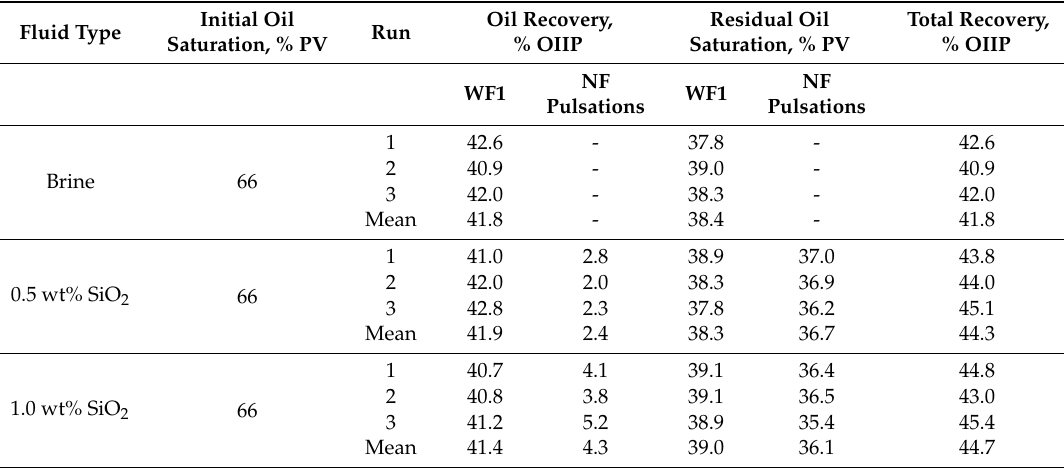
Table 4. Summary of sand-pack experiments where the initial water and oil volumes are fixed at 93.2 mL and the initial oil volume is 186.4 mL, respectively. Where %PV is the percentage of pore volume, OIIP is the oil initially in place, WF1 is the water-flooding stage, and NF represents the nanofluid